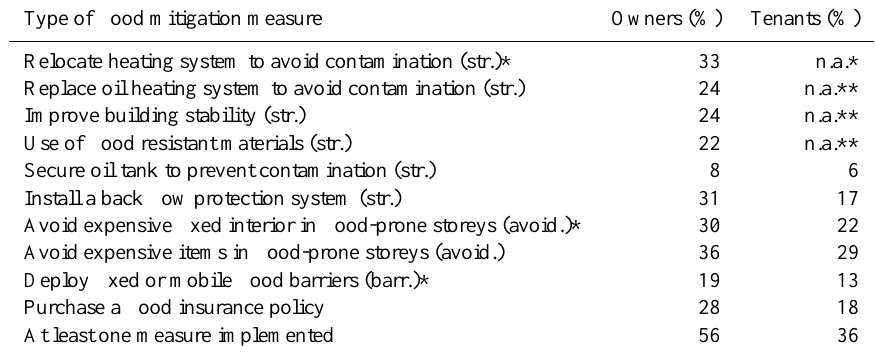
Table 1. Current implementation level of various flood mitigation measures among house owners ( n = 457) and tenants ( n = 295) along the Rhine.